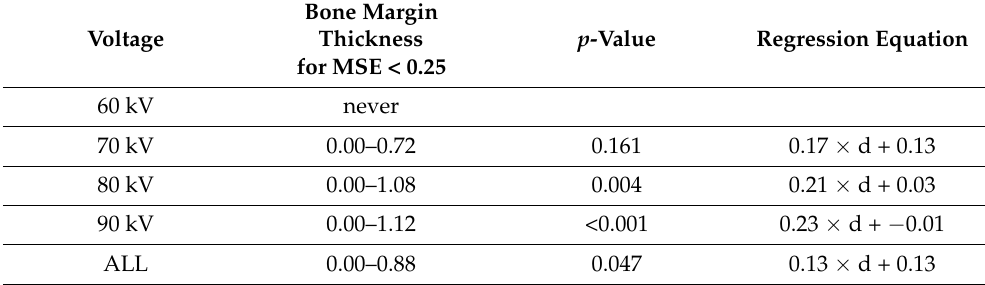
Table 4. Linear regression